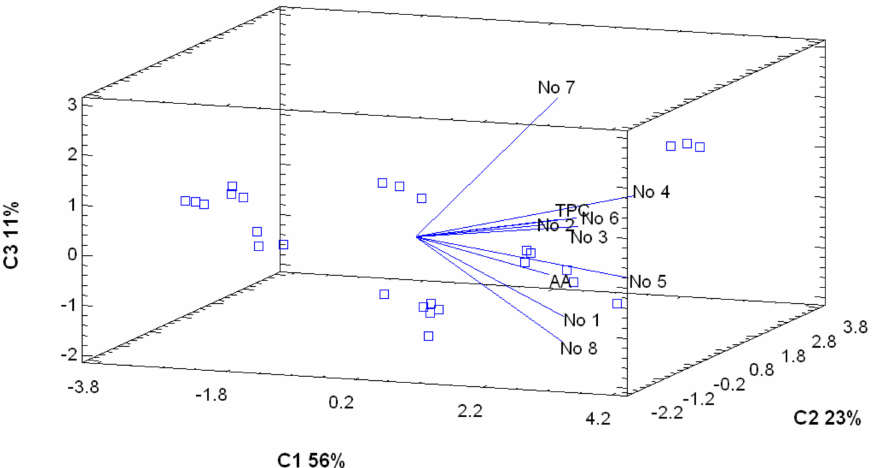
Figure 5. Principal components analysis of the tested parameters in pericarp. C1: Component 1; C2: